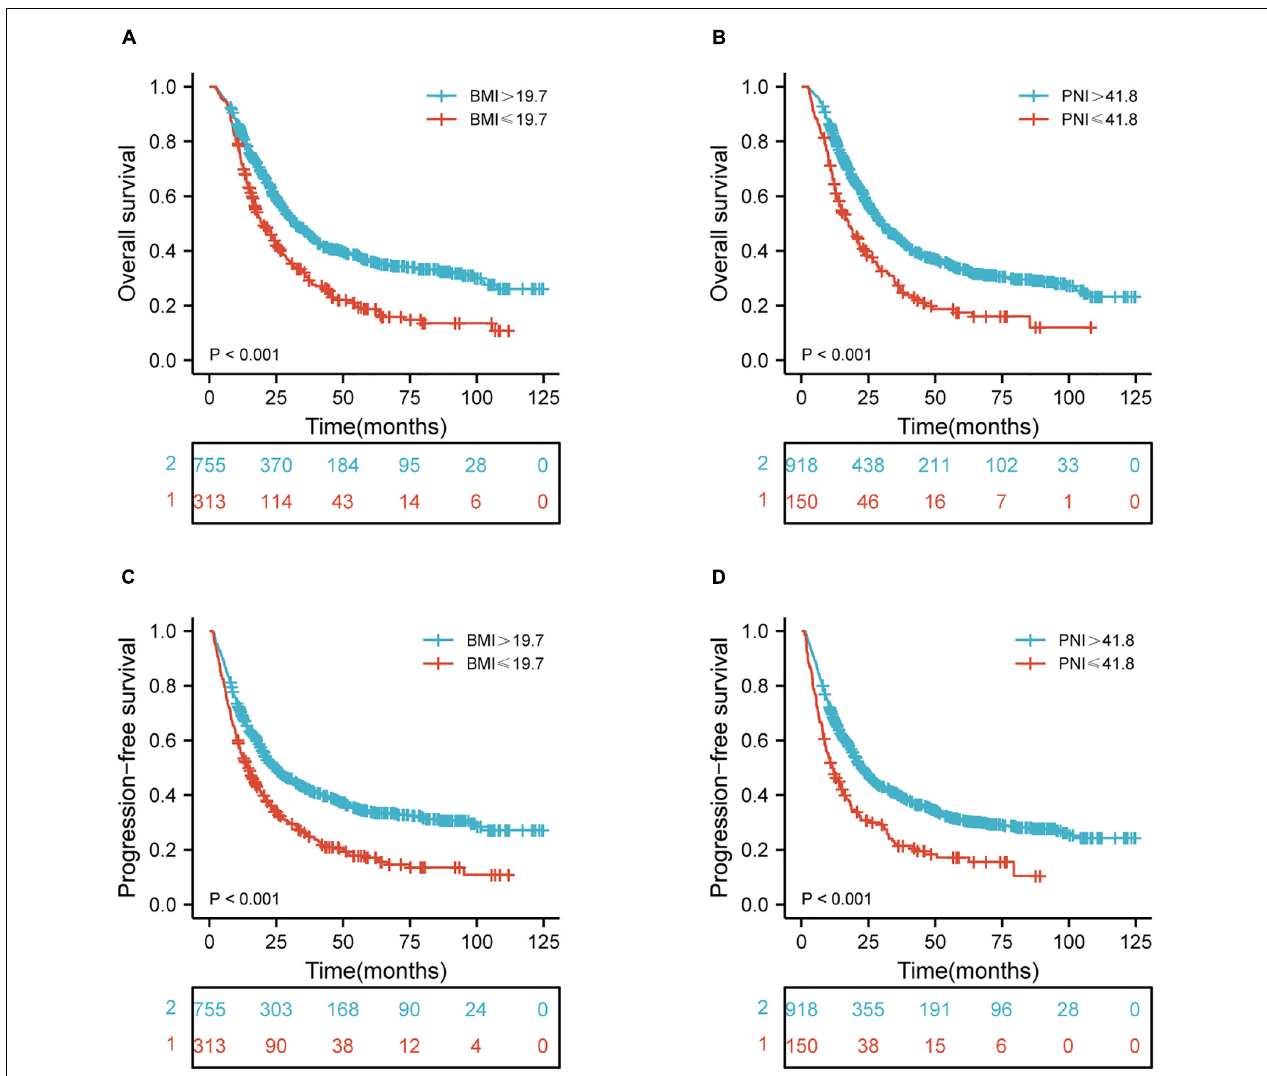
FIGURE 1 | Kaplan-Meier curves of BMI and PNI for the 1,068 patients showing (A,B) overall survival ( p < 0.001, p < 0.001, respectively); (C,D) progression-free survival ( p < 0.001, p < 0.001, respectively). BMI, body mass index; PNI, prognostic nutritional